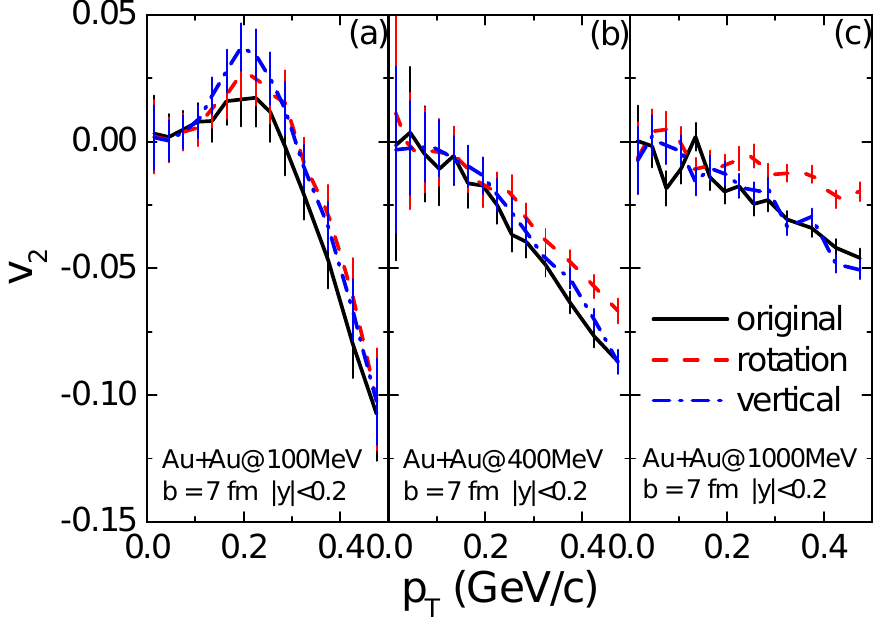
Figure 8. Transverse momentum dependence of the elliptic flow of midrapidity ( | y | < 0.2) free nucleons from three collision prescriptions in non-central Au+Au collisions at E lab = 100 ( a ); 400 ( b ); and 1000 ( c )